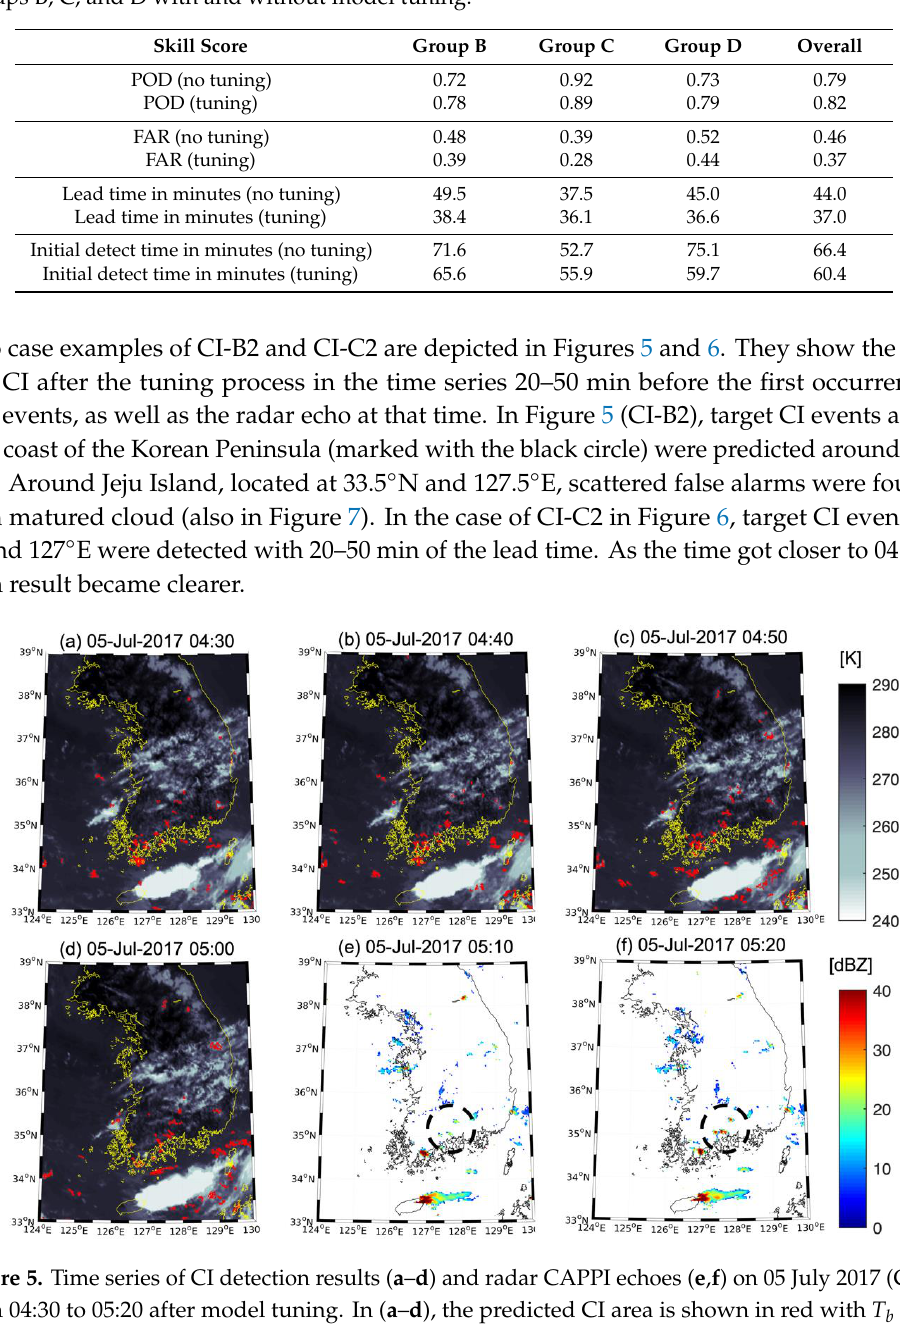
Table 4. The score of the probability of detection (POD), false alarm rate (FAR), and lead-time for test Groups B, C, and D with and without model tuning.